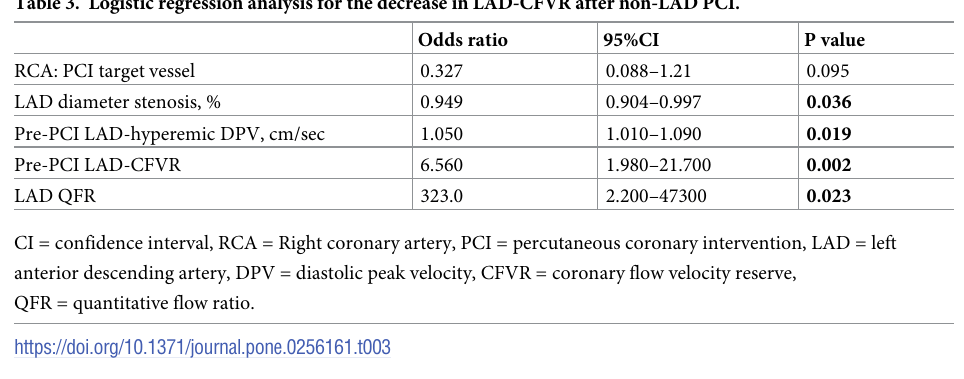
Table 3. Logistic regression analysis for the decrease in LAD-CFVR after non-LAD PCI.